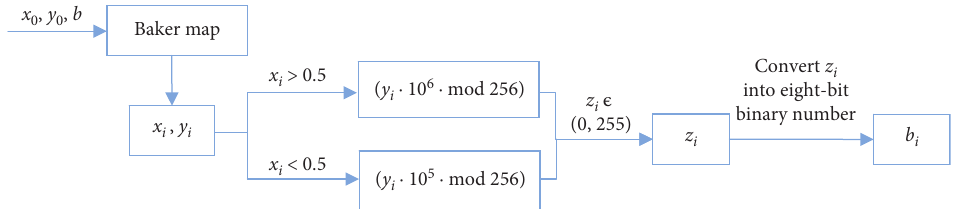
Figure 11: Schematic block diagram of the proposed PRBG. Table 3: NIST statistical test results.